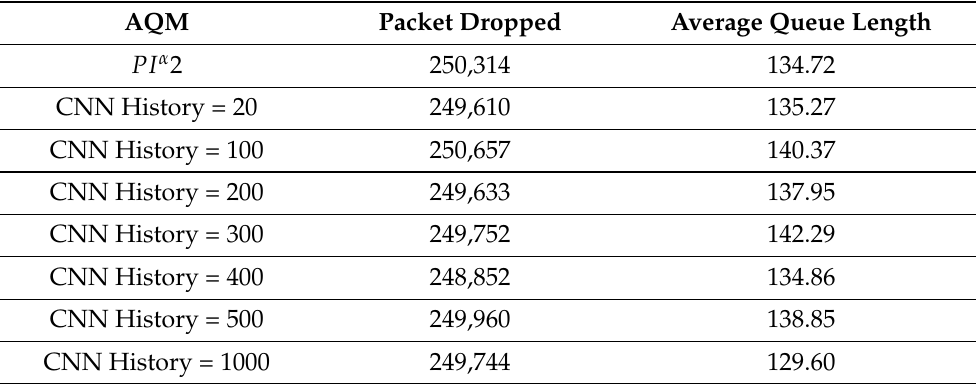
Table 10. Detailed results of queue occupancy obtained for CNN model with the last layer activation function Sigmoid, trained using data regarding PI α 2 controller parameters: K P = 0.0001, K I = 0.0004, α = − 0.5 and H =